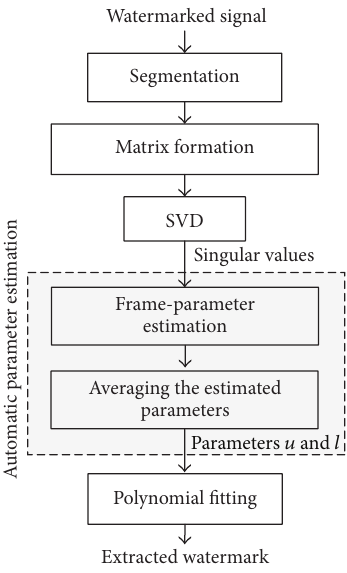
Figure 11: Extraction process.